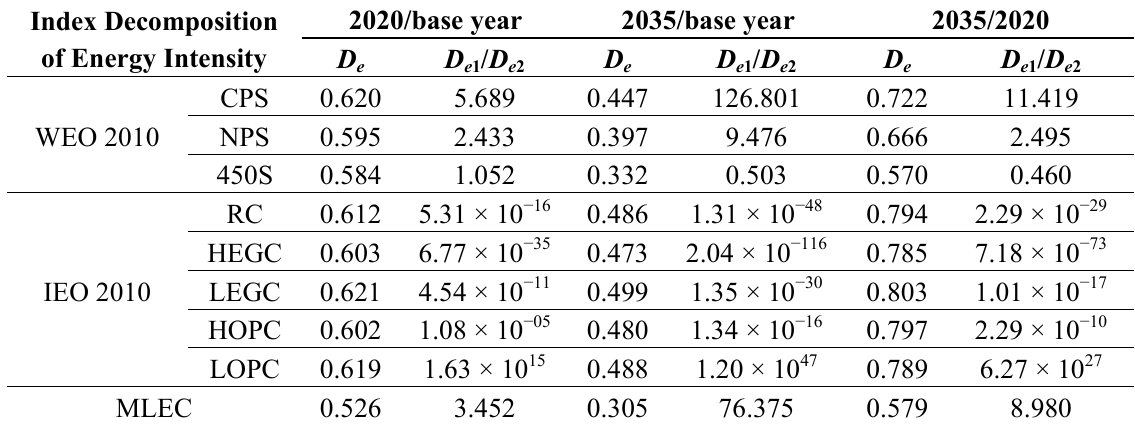
Table 5. Summary of the decomposition